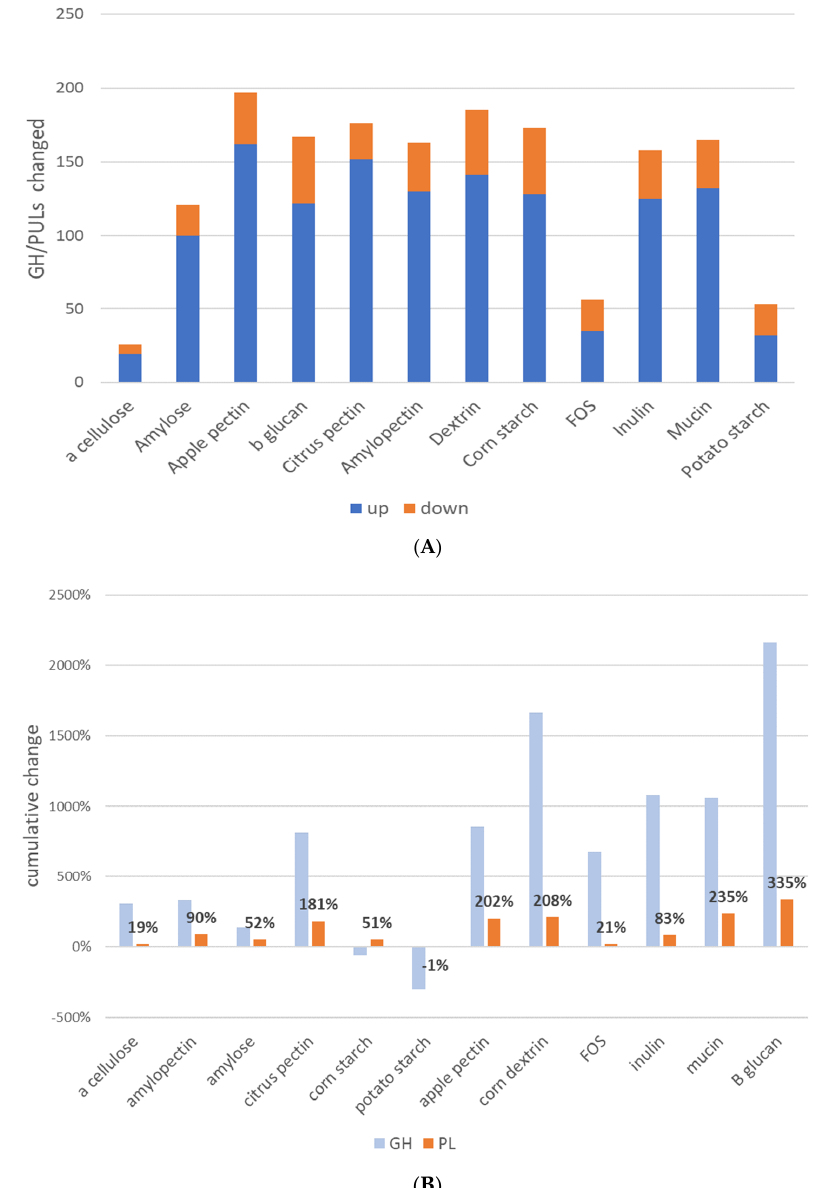
Figure 3. ( A ). Prebiotics alter CAZyme representation. GH and PL family representation were